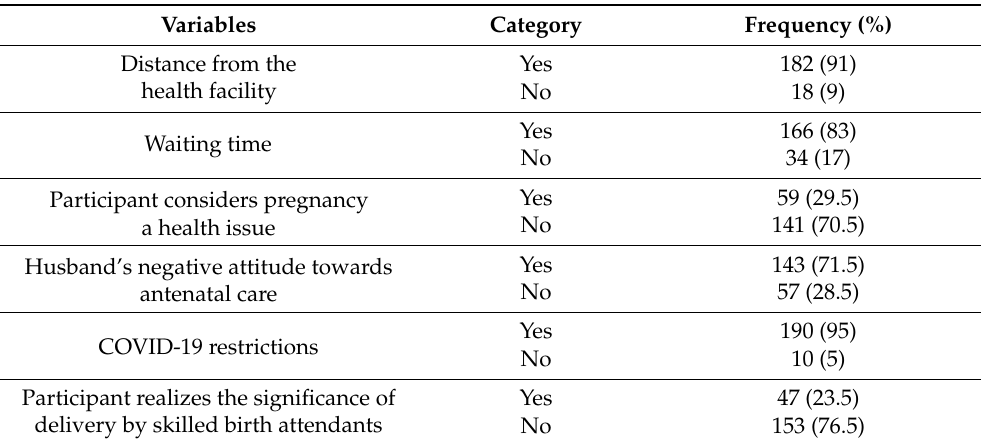
Table 3. Perceived hurdles in accessing antenatal healthcare services.